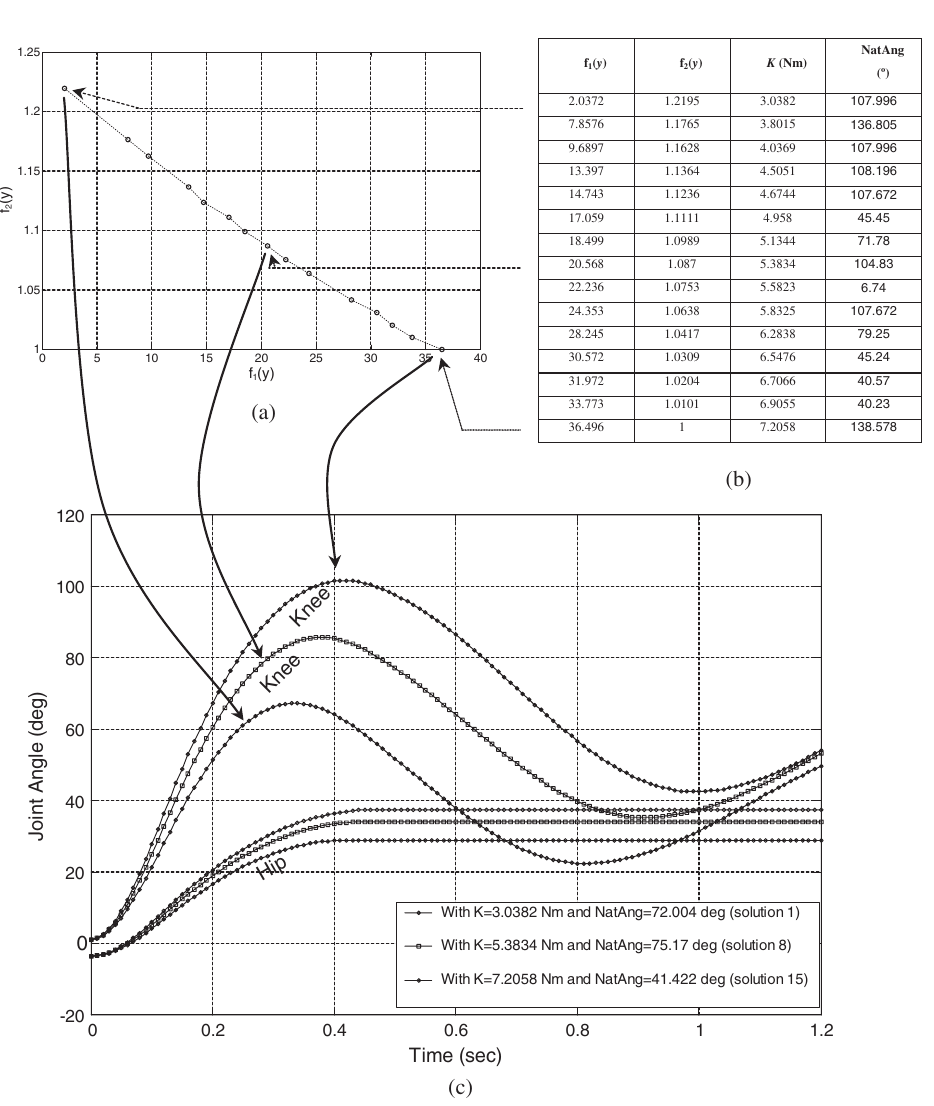
Fig. 10. Constant-torque spring parameters optimization with MOGA (a) Set of Pareto-optimal solutions (b) Table containing the set of Pareto-optimal solutions with the corresponding spring parameter values (c) Limb joint trajectories corresponding to different Pareto-optimal